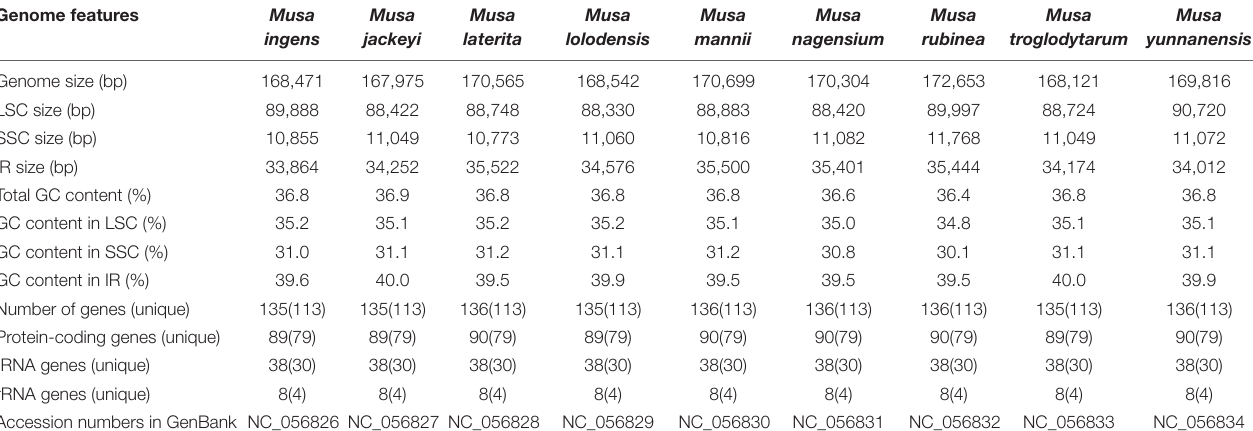
TABLE 1 | Chloroplast genome features of nine species of Musa